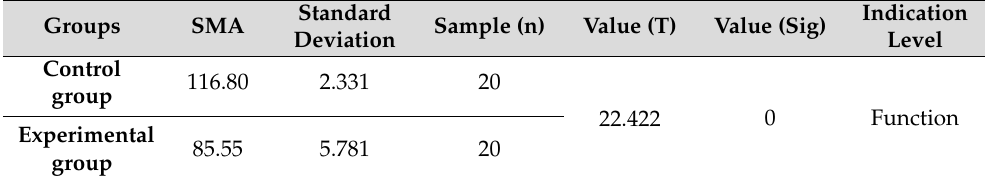
Table 5. Significance of differences between averages of experimental and control group in post- application of skills of practical experiments.